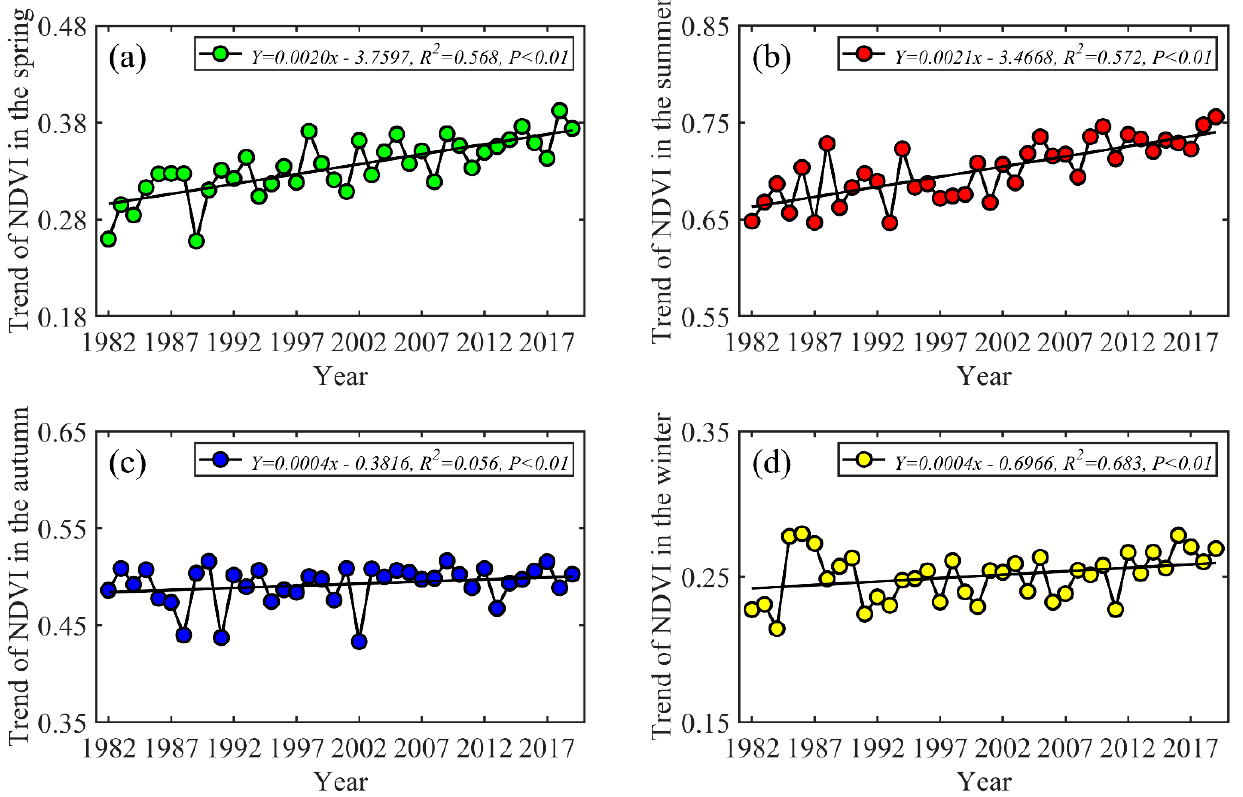
Figure 4. Seasonal trends of the NDVI in the RWA from 1982–2018. Note: ( a – d ) are the NDVI trends for spring, summer, autumn, and winter, respectively. The R 2 and P in the legend of each subplot are the coefficient of determination and significance values, respectively.